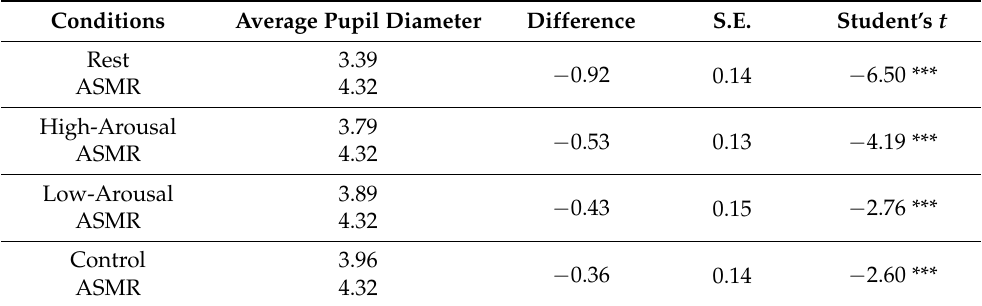
Table 5. Dependent sample t -test analysis of pupil diameter between ASMR and other